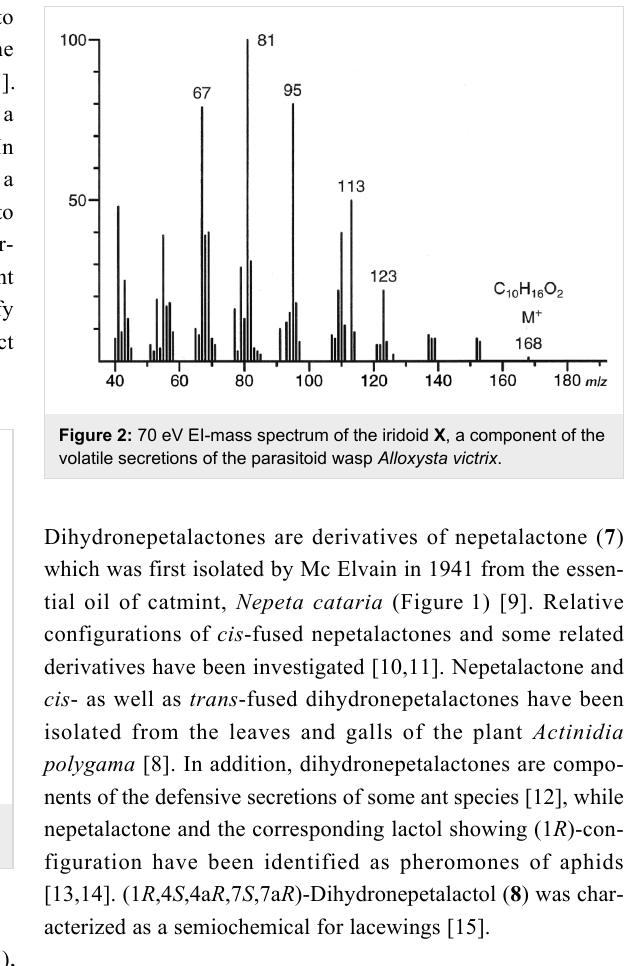
Figure 1: Terpenoids 1 – 5 present in Alloxysta victrix and cis -fused bicyclic iridoids known from other insects ( 6 – 8 ).